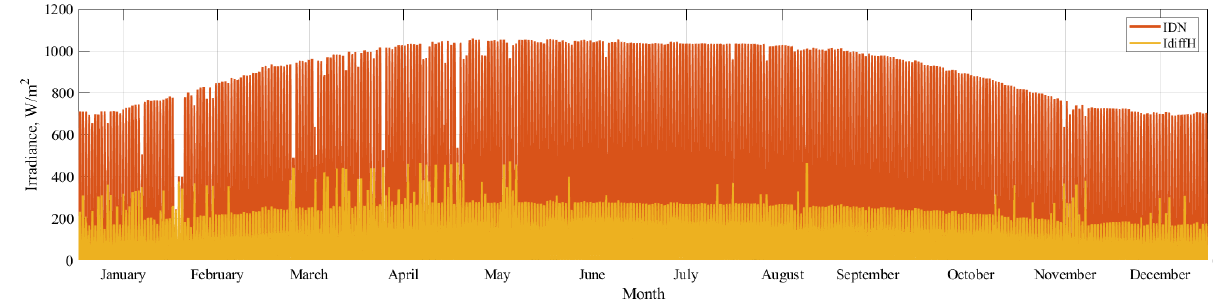
Figure 8. The hourly variation of solar radiation along the year for Riyadh, KSA generated with data from [33].